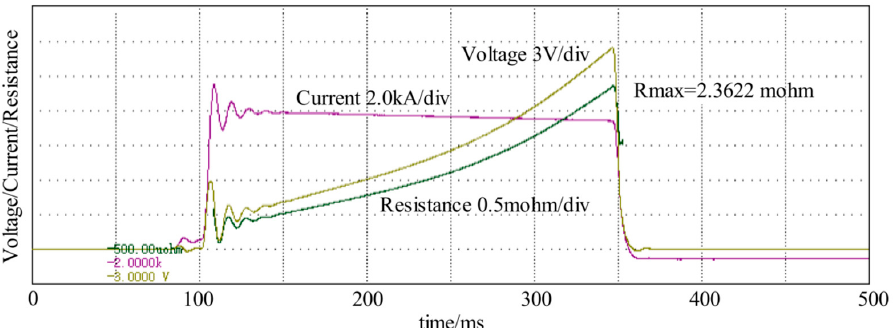
Figure 15. A high impulse current test of phase A.